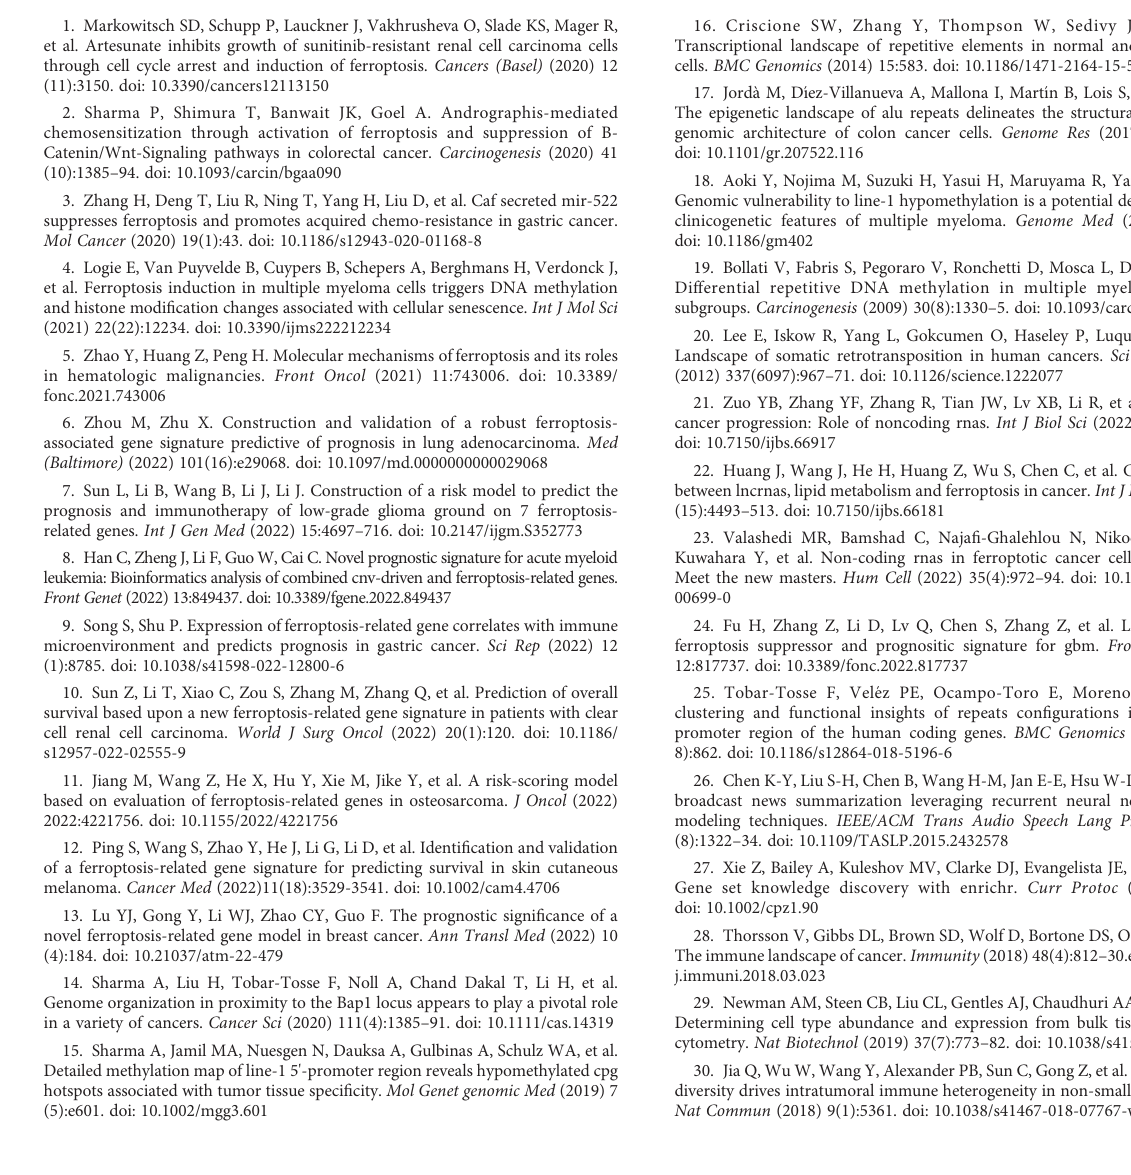
SUPPLEMENTARY FIGURE 10 Relationship between immune in fi ltration level and ferroptosis-related fourteen-gene risk score. The distribution of immune score, stromal score and tumor purity upon different risk score in the training cohort (A – C) and validationcohort (D – F) .Thecorrelationbetweenriskscoreandthedistribution of immune score (G) , stromal score (H) and tumor purity (I) , respectively. *p< 0.05, **p< 0.01, ***p< 0.001. SUPPLEMENTARY FIGURE 11 Cox proportional hazards regression models based on the enrichment level of28 immunein fi ltration-related gene sets via ssGSEA analyses in (A) MMRF-COMMPASS study and (B) GSE24080. Red stars indicate